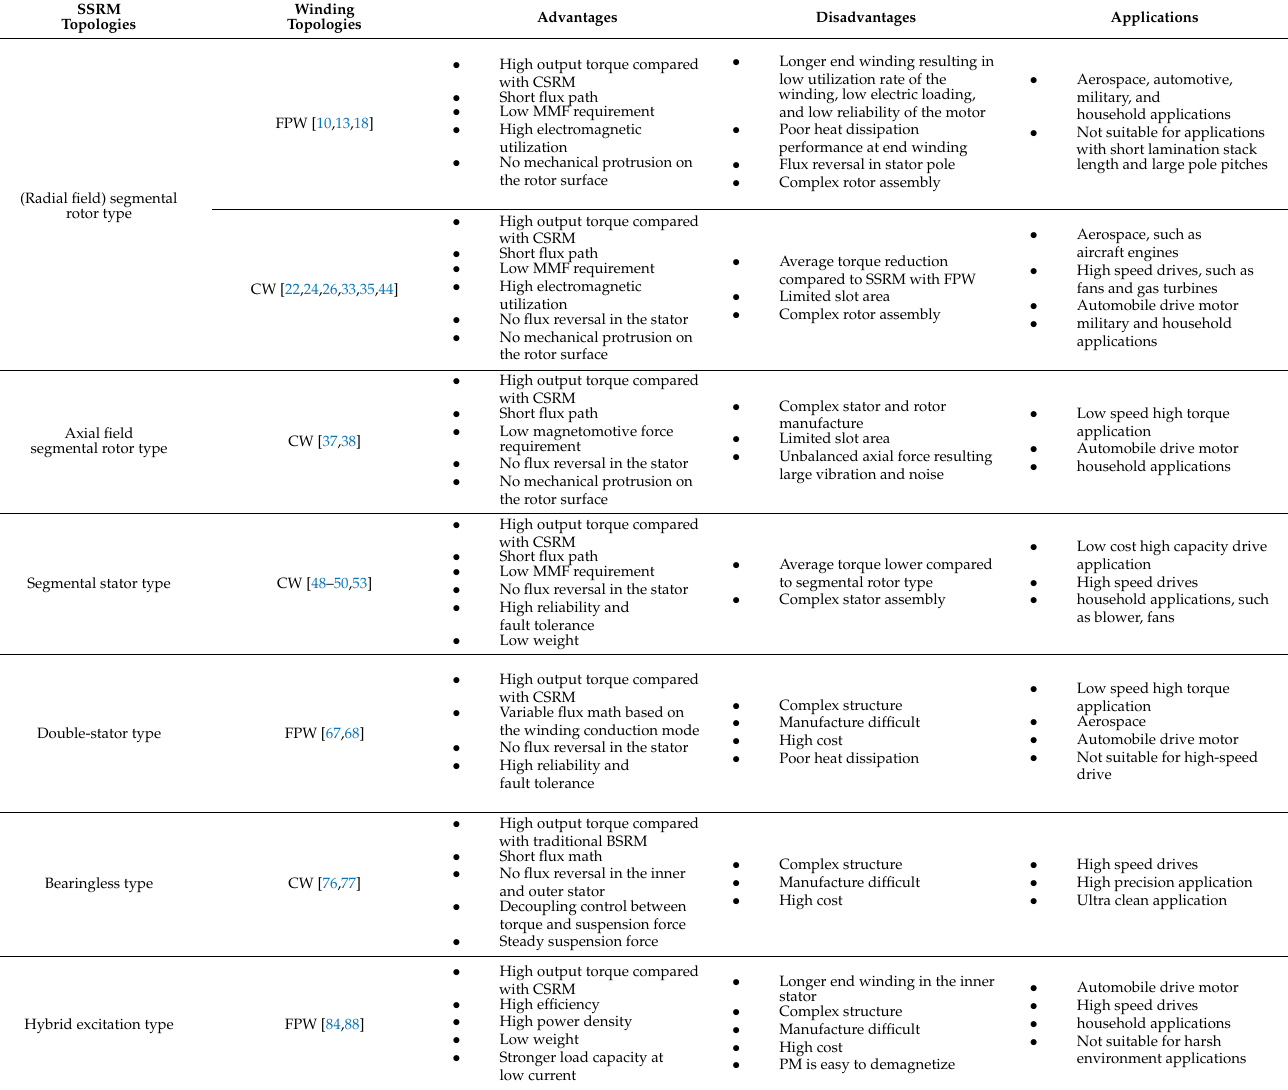
Table 1. Comparison of advantages, disadvantages, and applications of various